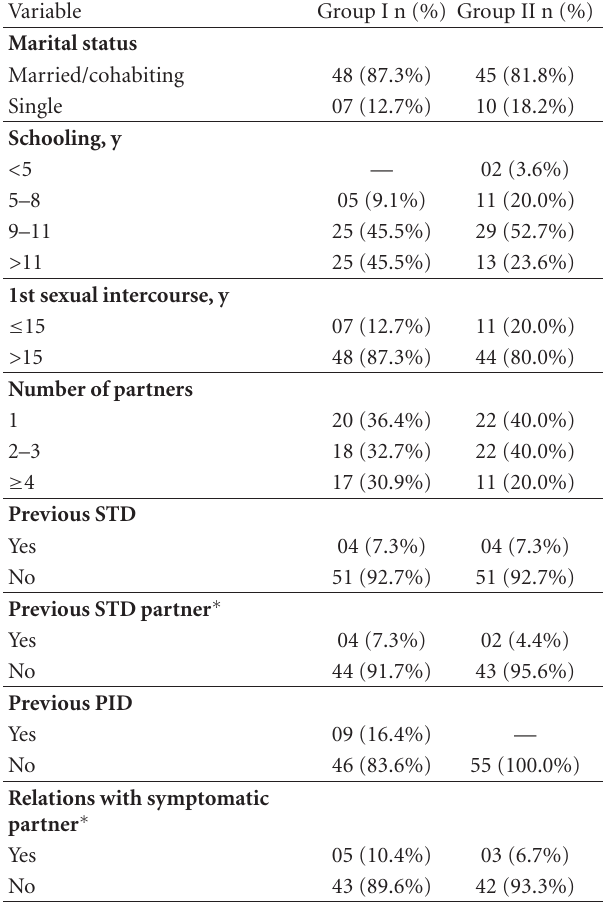
Table 1: Sociodemographic characteristics and sexual behavior of 55 women with tubal occlusion or previous ectopic pregnancy (group I) and 55 parous women (group II), from Goiˆania, Goi´as, Brazil, in 2001.